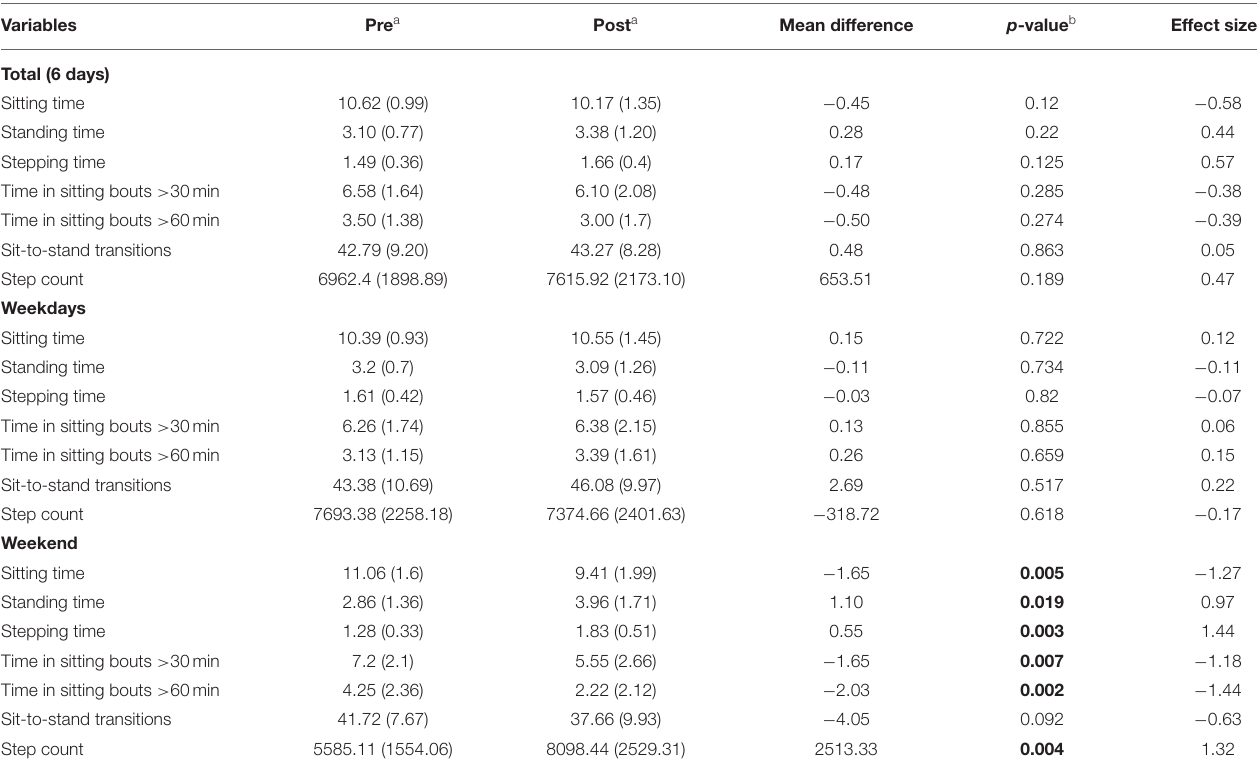
TABLE 4 | Descriptive statistics and pre-post comparison (paired t -tests) for the activPAL outcomes ( n = 9).